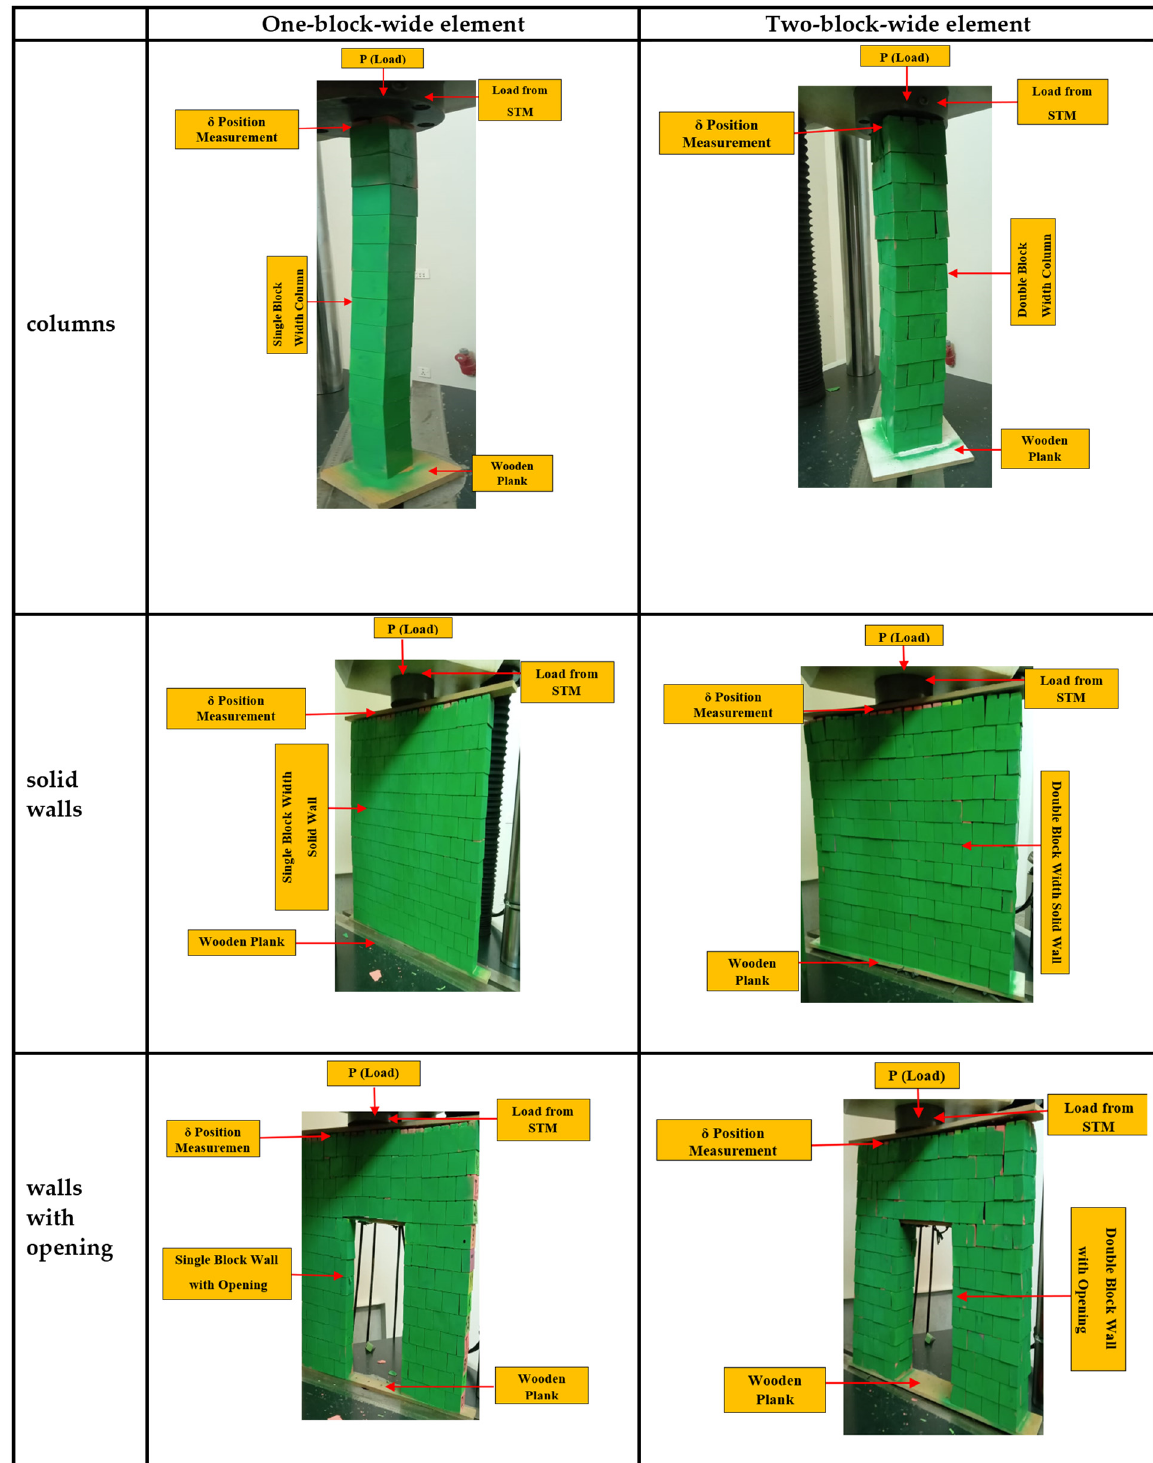
Figure 5. Test setups and instrumentation of interlocking-plastic-block structural elements under consideration.